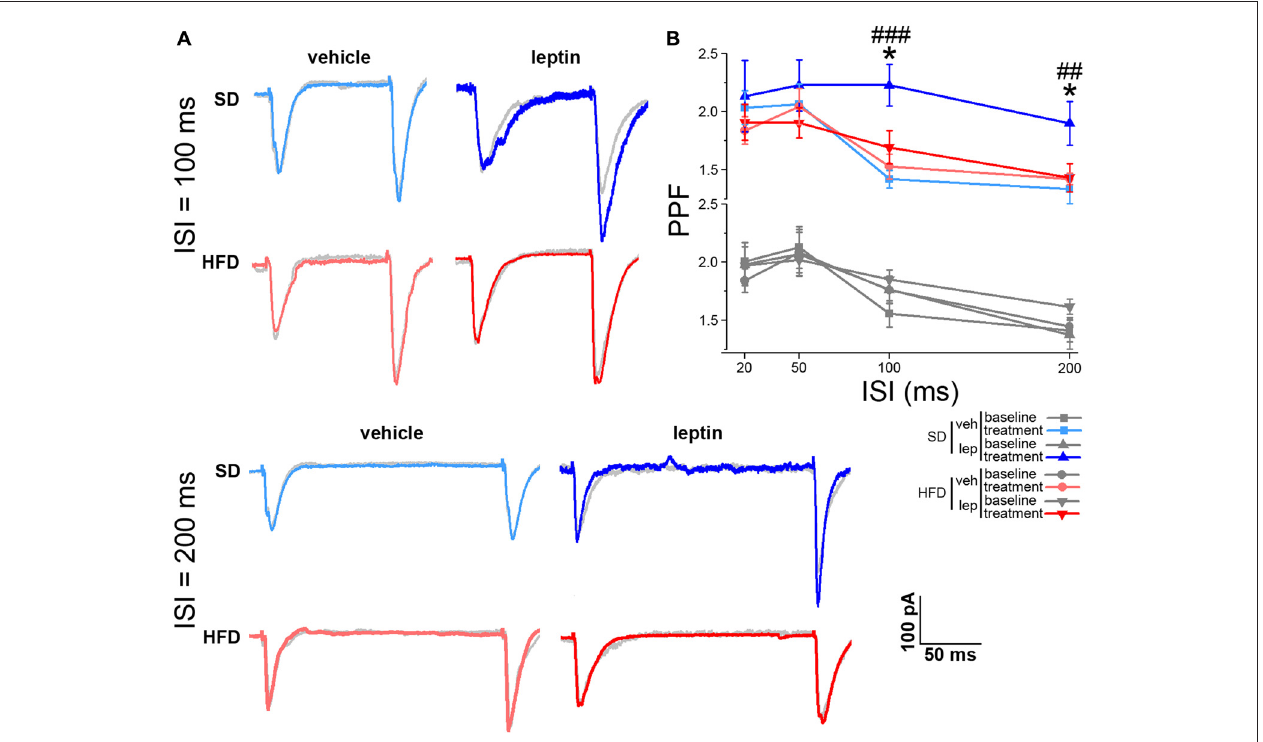
FIGURE 3 | HFD mice are resistant to leptin-mediated increase in paired-pulse facilitation (PPF). (A) Representative traces showing EPSCs evoked by pair of stimuli delivered to the Schaffer Collateral (SC) at 100 ms (upper panel) and 200 ms (lower panel) interstimulus intervals (ISIs). The post-treatment response is superimposed to the baseline response of the same cell, depicted in gray. (B) Leptin treatment increases PPF at 100 ms (SD-veh n = 10, SD-lep n = 10, HFD-veh n = 11, HFD-lep n = 14; ANOVA-2, diet × treatment interaction, p = 0.022, followed by Bonferroni post hoc test, SD-lep vs. SD-veh, ### p < 0.001, SD-lep vs. HFD-lep, ∗ p = 0.013) and 200 ms (SD-veh n = 10, SD-lep n = 10, HFD-veh n = 11, HFD-lep n = 14; ANOVA-2, diet × treatment interaction, p = 0.009, followed by Bonferroni post hoc test, SD-lep vs. SD-veh, ## p = 0.005, SD-lep vs. HFD-lep, ∗ p = 0.02) ISI in SD mice; in contrast, HFD mice are resistant to the action of leptin on PPF. Baseline and post-treatment plots have been separated to increase clarity. Both plots are shown on the same range, with no